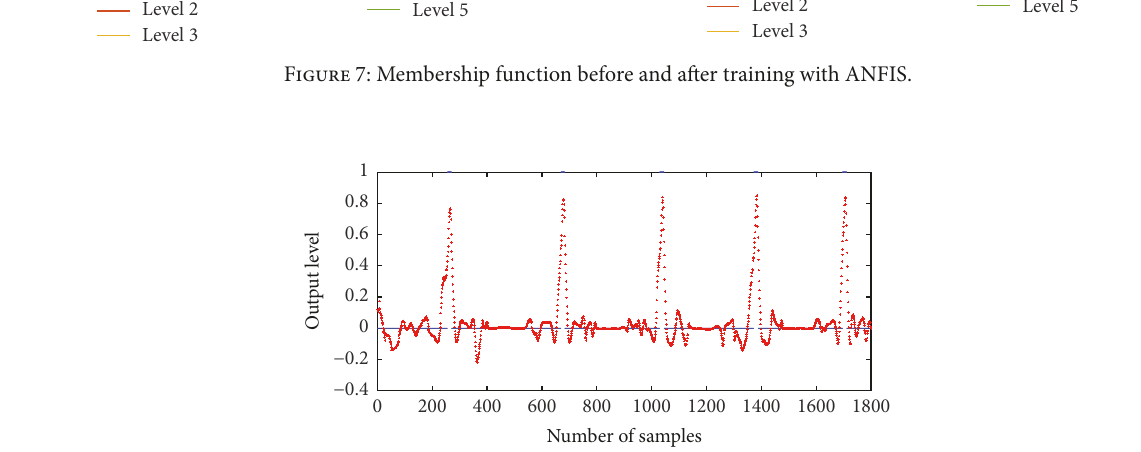
Figure 8: Comparison between the fusion results with ANFIS predicted output level and the reference output